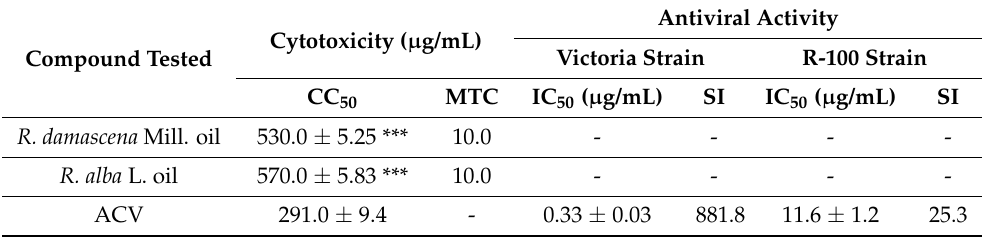
Table 1. Cytotoxicity (on MDBK cells) and anti-HSV-1 activity of Rosa damascena Mill. and Rosa alba L. essential oils.